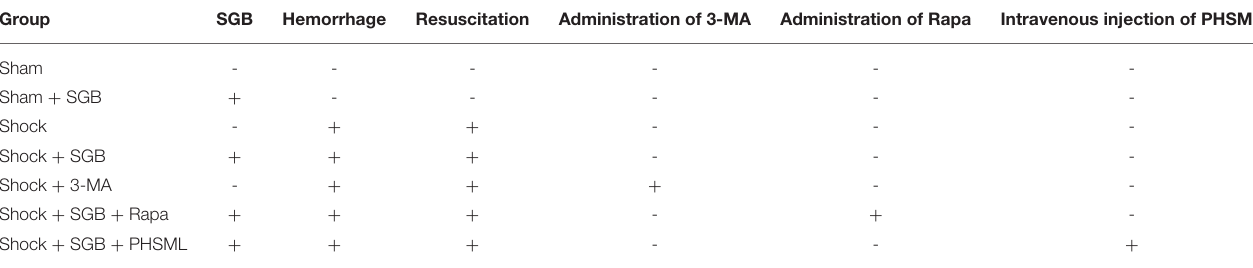
TABLE 1 | Experimental procedure in various groups in animal experiment.